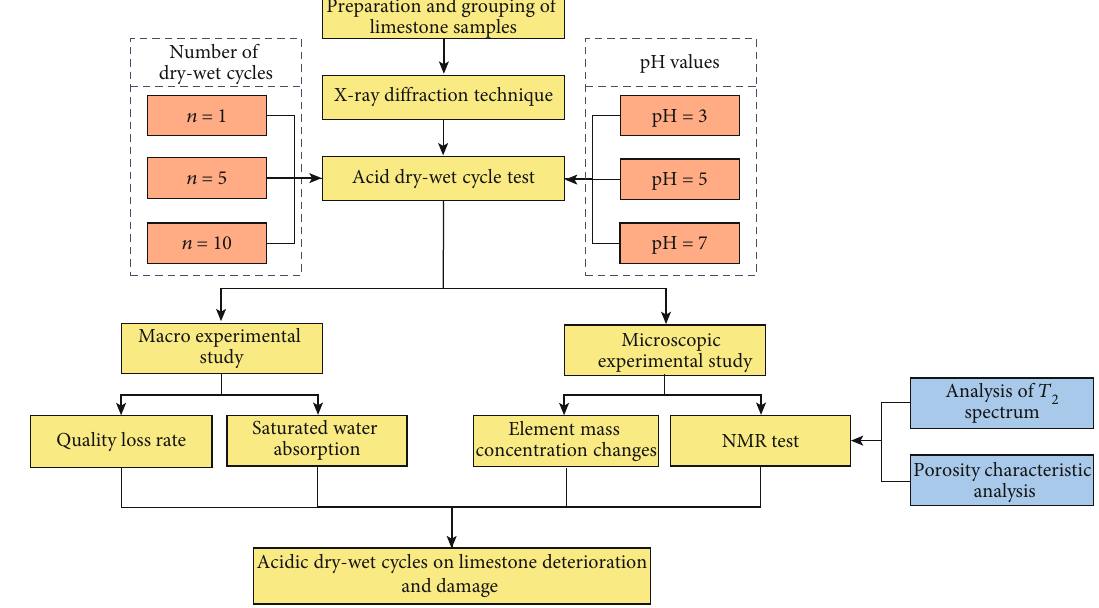
Figure 3: Flow chart of the experimental design. Table 2: Limestone sample numbering